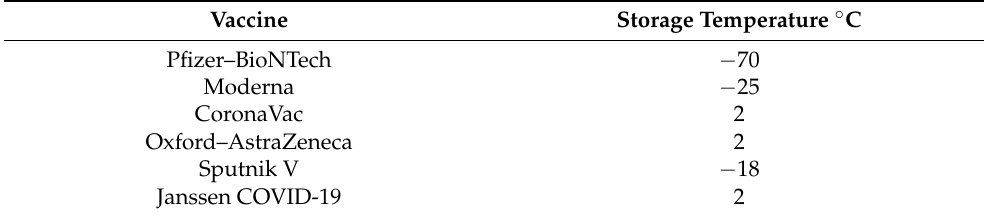
Table 1. Vaccine storage